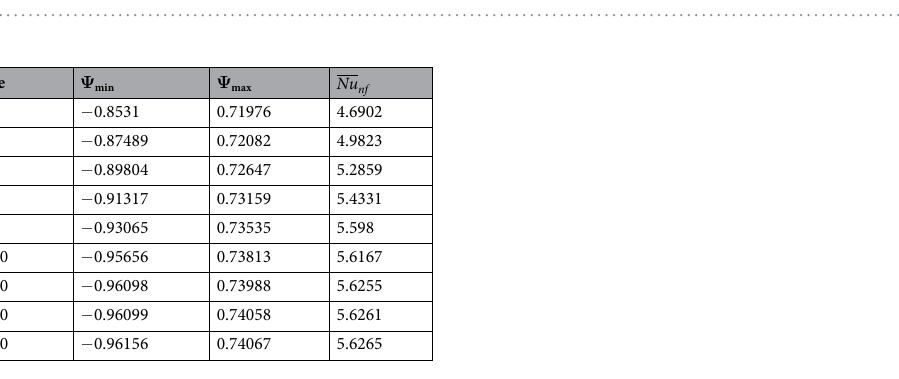
Table 1. Grid testing for Ψ min , Ψ max and Nu D =